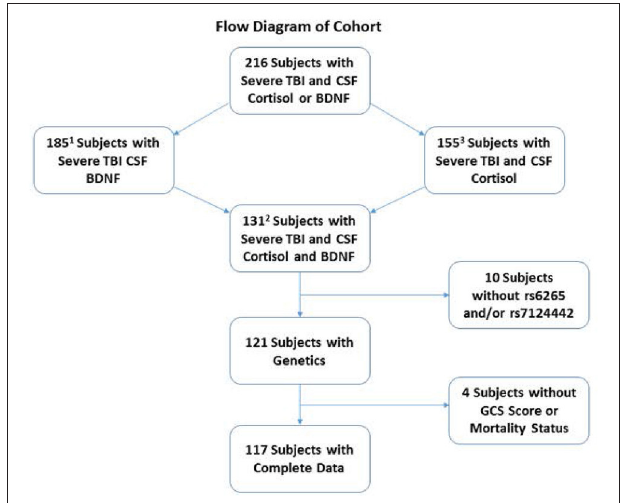
FIGURE 1 | Diagram depicting how the cohort was derived for analysis. The cohort was restricted to self-reported White individuals with complete demographic, clinical, genetics and biomarker data. There were a total of 216 White severe TBI subjects with CSF Cortisol and BDNF. Of these, 185 and 155 subjects had CSF BDNF and cortisol, respectively. A total of 131 subjects had both CSF cortisol and BDNF. A total of 14 subjects were removed for missing BDNF genetics or GCS or mortality data, leaving a final cohort of 117. 1 Used for estimating prior distributions in the mediation analysis path for BDNF-mortality (total effect). 2 Used for estimating prior distributions in the mediation analysis path of BDNF-cortisol, cortisol-mortality, and BDNF-mortality (direct effect). 3 Used to generate CSF cortisol trajectories in the most inclusive cohort with CSF